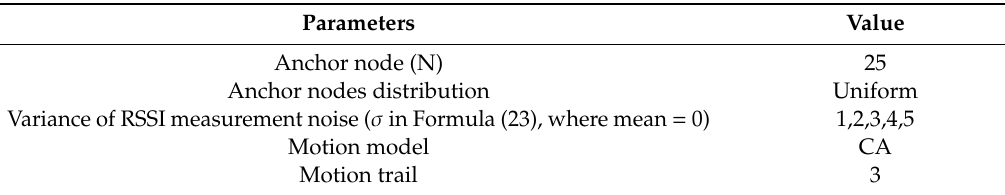
Table 6. Parameter settings.